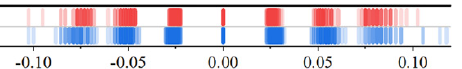
Figure 8. Schematic diagram comparing the numerical fluctuation frequency in the DSI between the STAA and the TDAA [11] (red represents the STAA and blue represents the TDAA [11]).